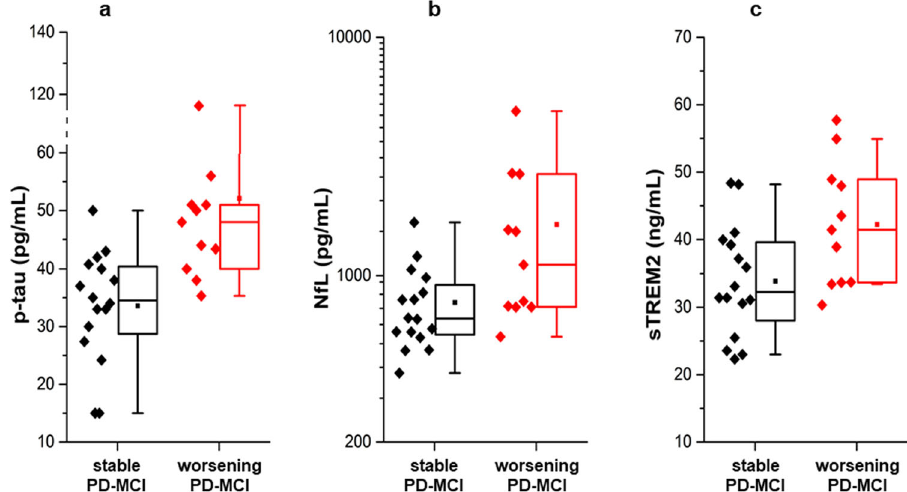
Fig. 3 Box plots showing differences in CSF biomarkers levels between PD-MCI patients showing at least 2 point-loss at both MMSE and MoCA (worsening PD-MCI, red) and PD-MCI without cognitive worsening (stable PD-MCI, black). a difference in CSF p-tau between worsening PD-MCI and stable PD-MCI. b difference in CSF NfL between worsening PD-MCI and stable PD-MCI. c difference in CSF sTREM2 between worsening PD-MCI and stable PD-MCI. In boxplots, box height represents the interquartile range, the square represents the mean, the horizontal line represents the median and whiskers represent the 5 – 95% range. Biomarker values are shown in the log-scale for viewing purposes. NfL neuro fi lament light chain, p-tau phosphorylated tau protein, sTREM2 soluble triggering receptor expressed on myeloid cells